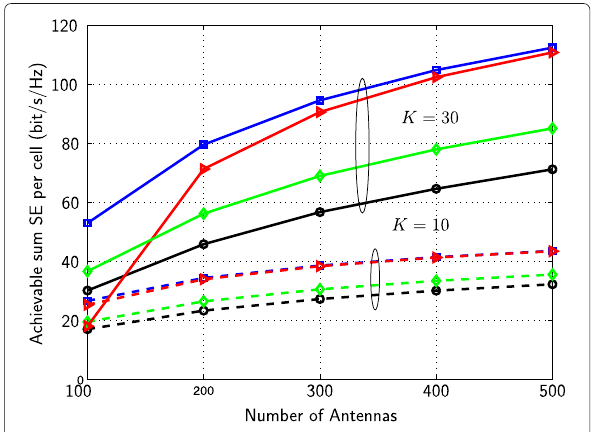
Fig. 4 Achievable sum SE of M-MMSE ( squares ), M-ZF ( triangles ), S-MMSE ( diamonds ), and MF ( circles ) with β = 3